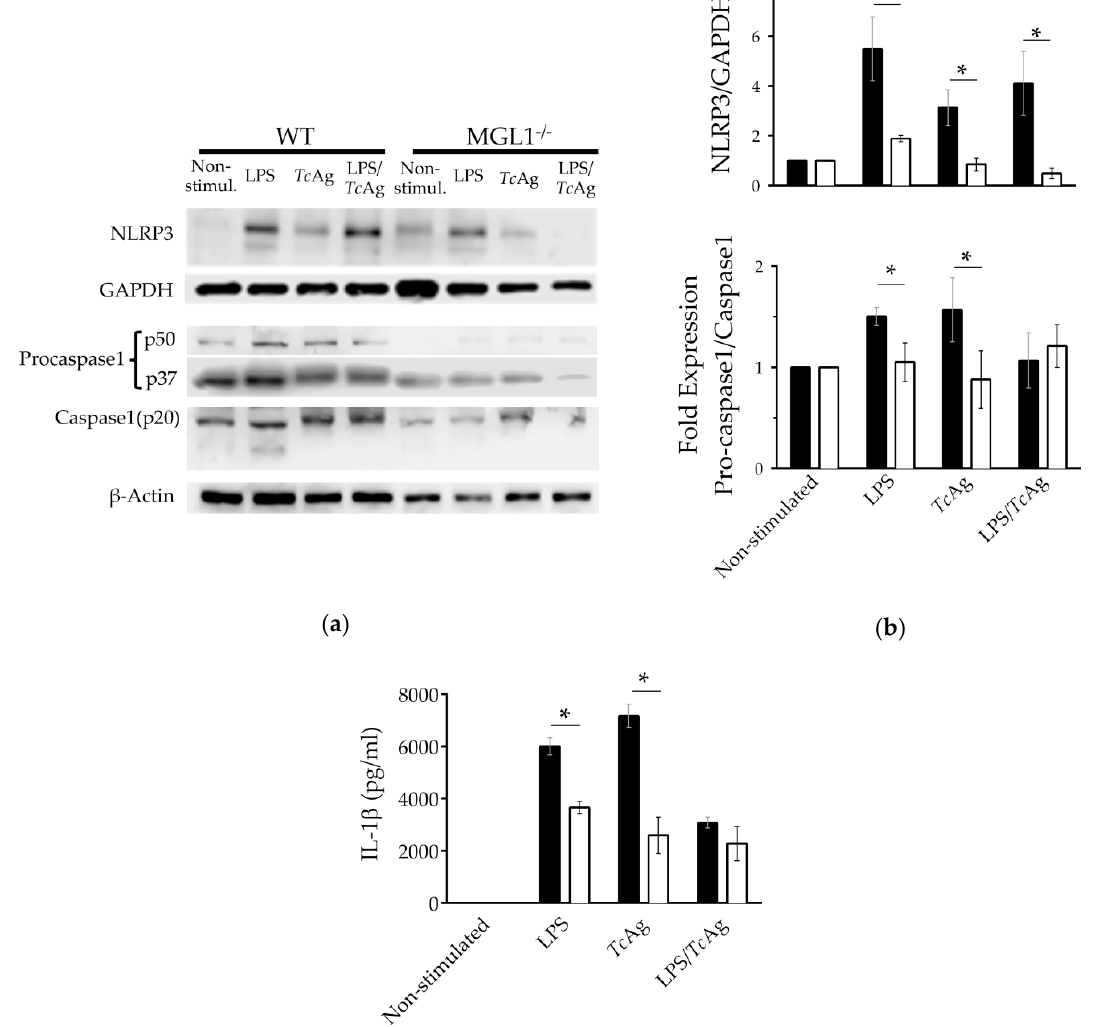
Figure 8. MGL1 is required for proper expression of NLRP3, pro-caspase1 / caspase1 and IL-1 β production. WT and MGL1 − / − BMM φ were stimulated for 24 h with LPS (100 ng/mL) or Tc Ag (25 µg/mL) or LPS+ Tc Ag (100 ng + 25 µg/ mL), in total protein lysates of M φ were measured NLRP3, pro-caspase1 and caspase1 by western blot. ( a ) Western blot showing down-regulated NLRP3, pro-caspase1 and caspase1 protein expression in MGL1 − / − M φ , and ( b ) the densitometry analysis for the NLRP3 and the fold expression of pro-caspase1/caspase 1. ( c ) ELISA quantification of IL-1 β in the cell culture supernatants. The western blot data were normalized to GAPDH control and are representative of two separate experiments. The data are plotted as the means (± SEM), n = 5, * p < 0.05.